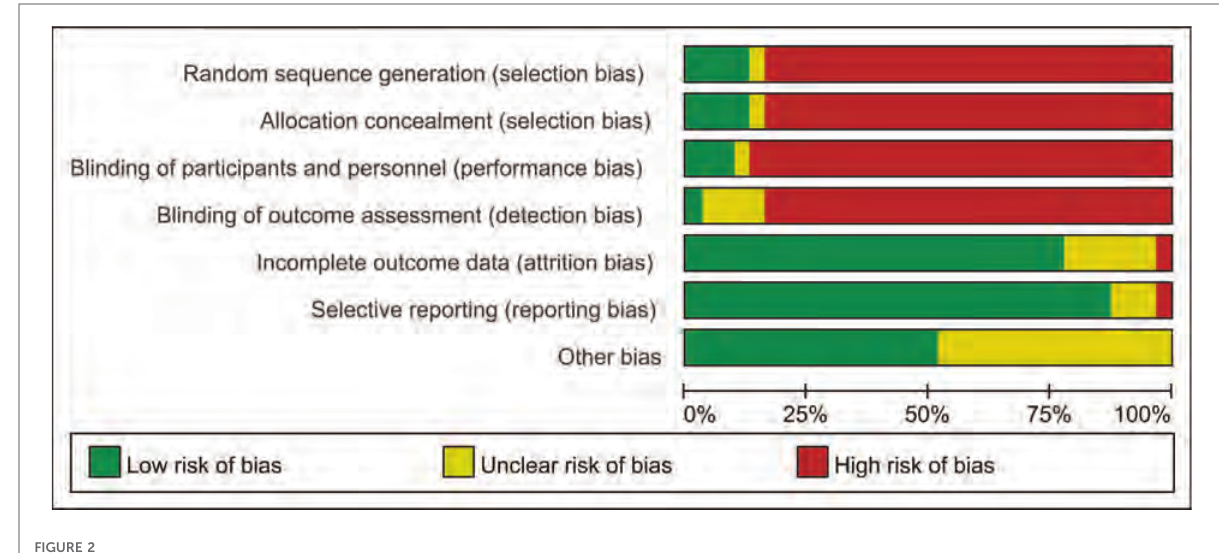
FIGURE 2 Risk of bias graph.